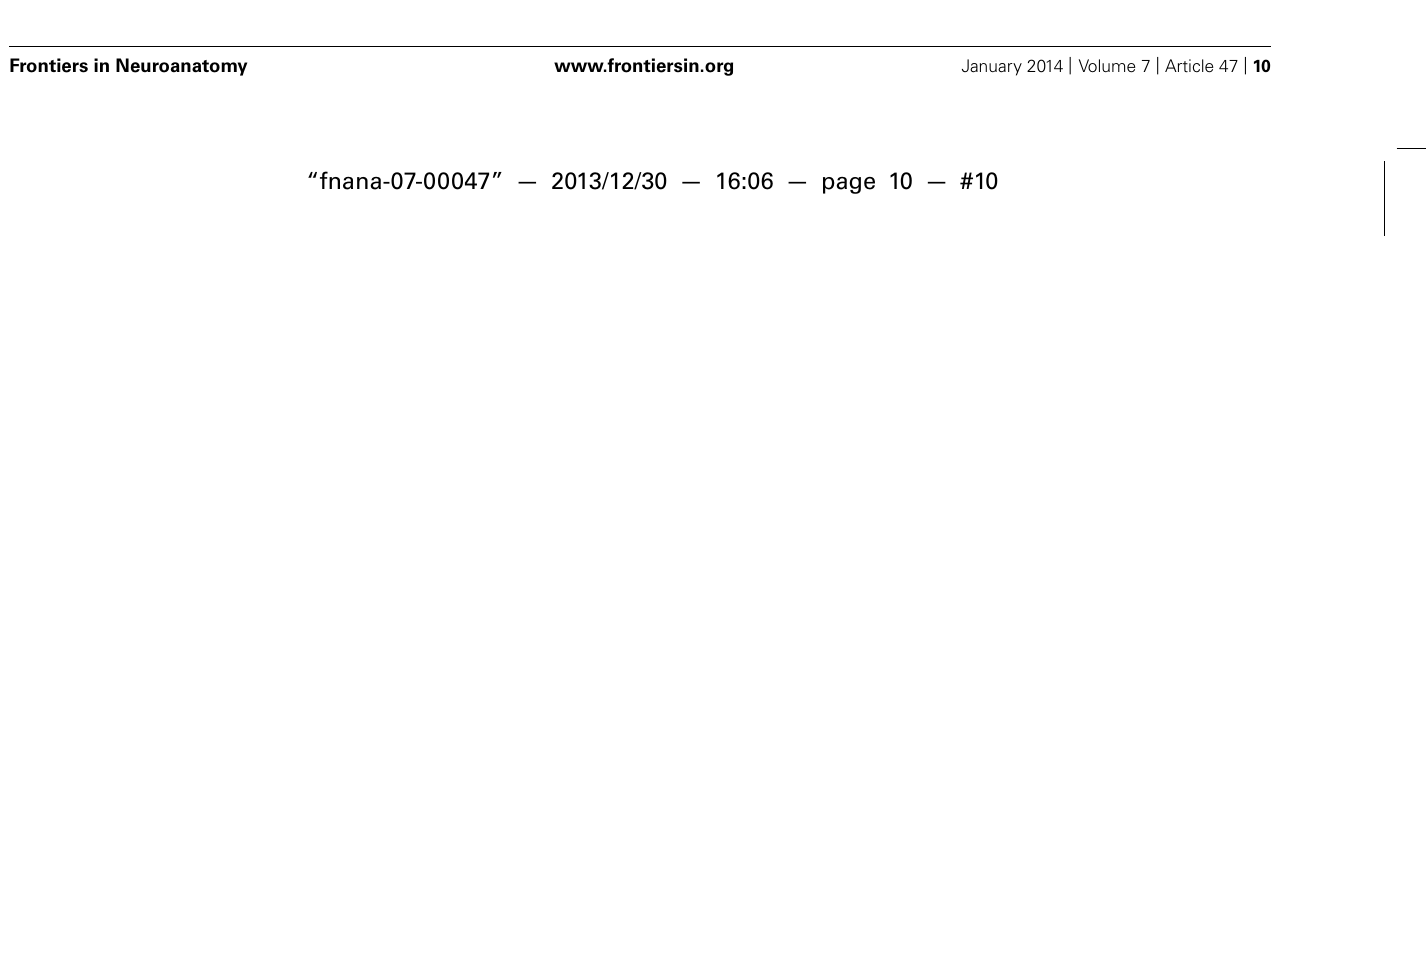
dendrite. (D) Temporal changes in the spine density of apical (open circles) and basal (closed circles) dendrites of CA1 pyramidal neurons. (E) Time course of the density of dendritic swellings, an aspect of neuronal degeneration. Significant morphological changes were observed between 8 and 12 DPI (asterisks in D and E ; p < 0.05, Mann–Whitney U test) (F) A segmented neuron at 12 DPI. Figures C–F were obtained using SADcvsG-HEP- Δ G-GFP. Scale bars = 20 μ m (A2,A3,B2,B3) and 100 μ m (A1,B1,F)